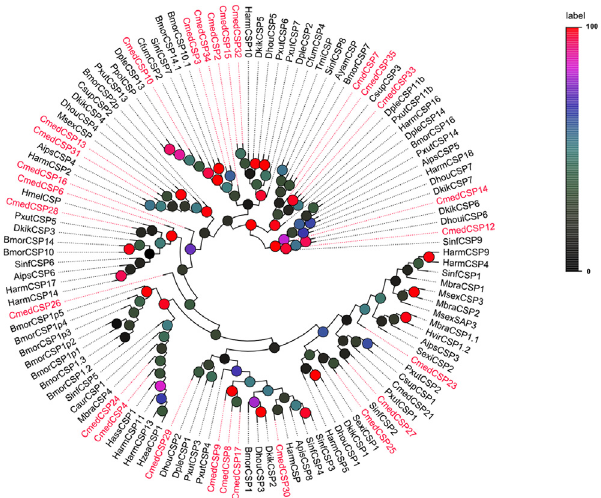
Fig 7. Phylogenetic tree of candidater CmedCSPs with known CSP sequences of other species. Harm: H . armigera ; Hvir: H . virescens ; Bmor: B . mori ; Pxyl: P . xylostella ; Hass: H . assulta ; Hzea: Helicoverpa zea